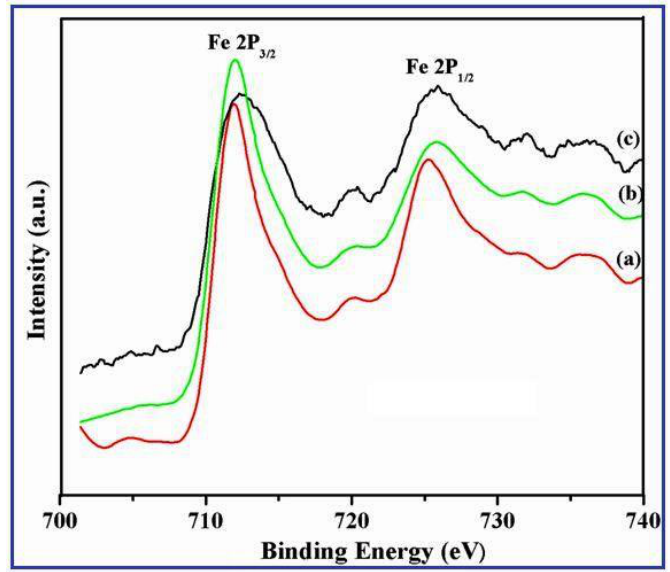
Figure 2. Core level XPS spectrum of γ-Fe 2 O 3 nanostructures synthesized using different % (1%, 2%